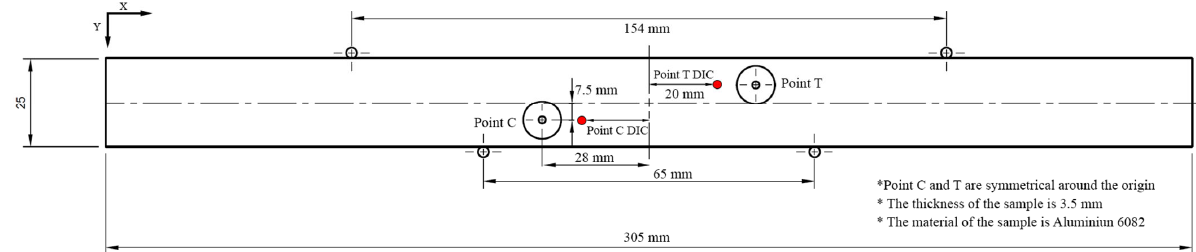
Figure 5. 4 ‐ point bending experimental setup with strain gauge positions (Point C and T), speckle pattern and DIC hole ‐ drilling locations (Point C DIC and T DIC) highlighted in red.